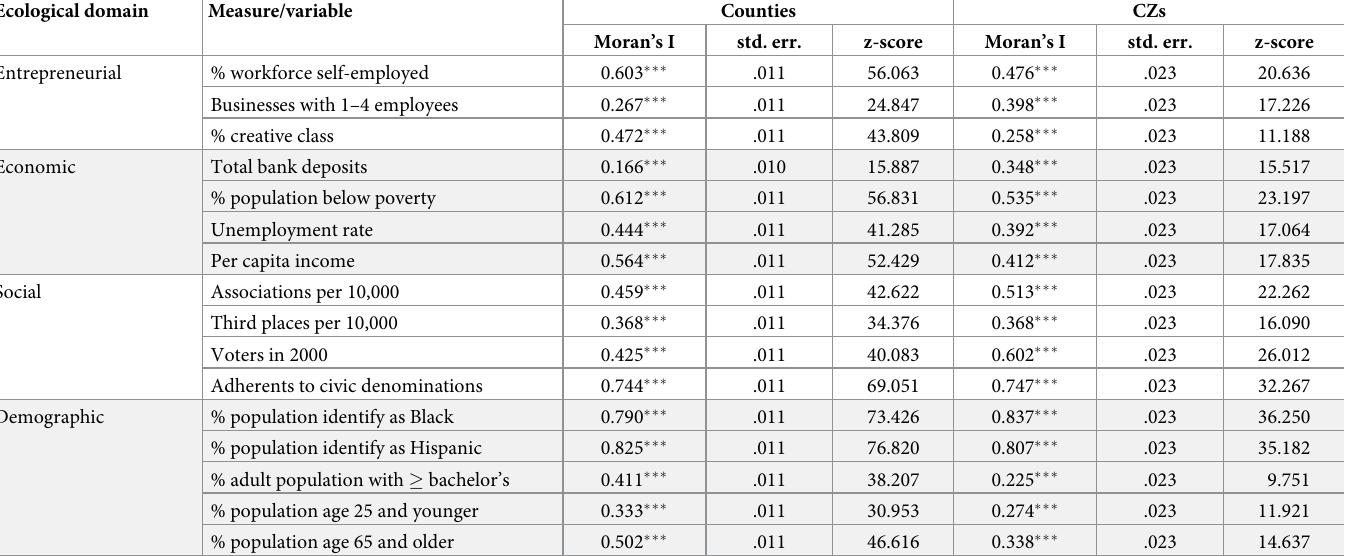
Table 2. Global Moran’s I for entrepreneurial, economic, social, and demographic domains (Counties vs. CZs). Ecological